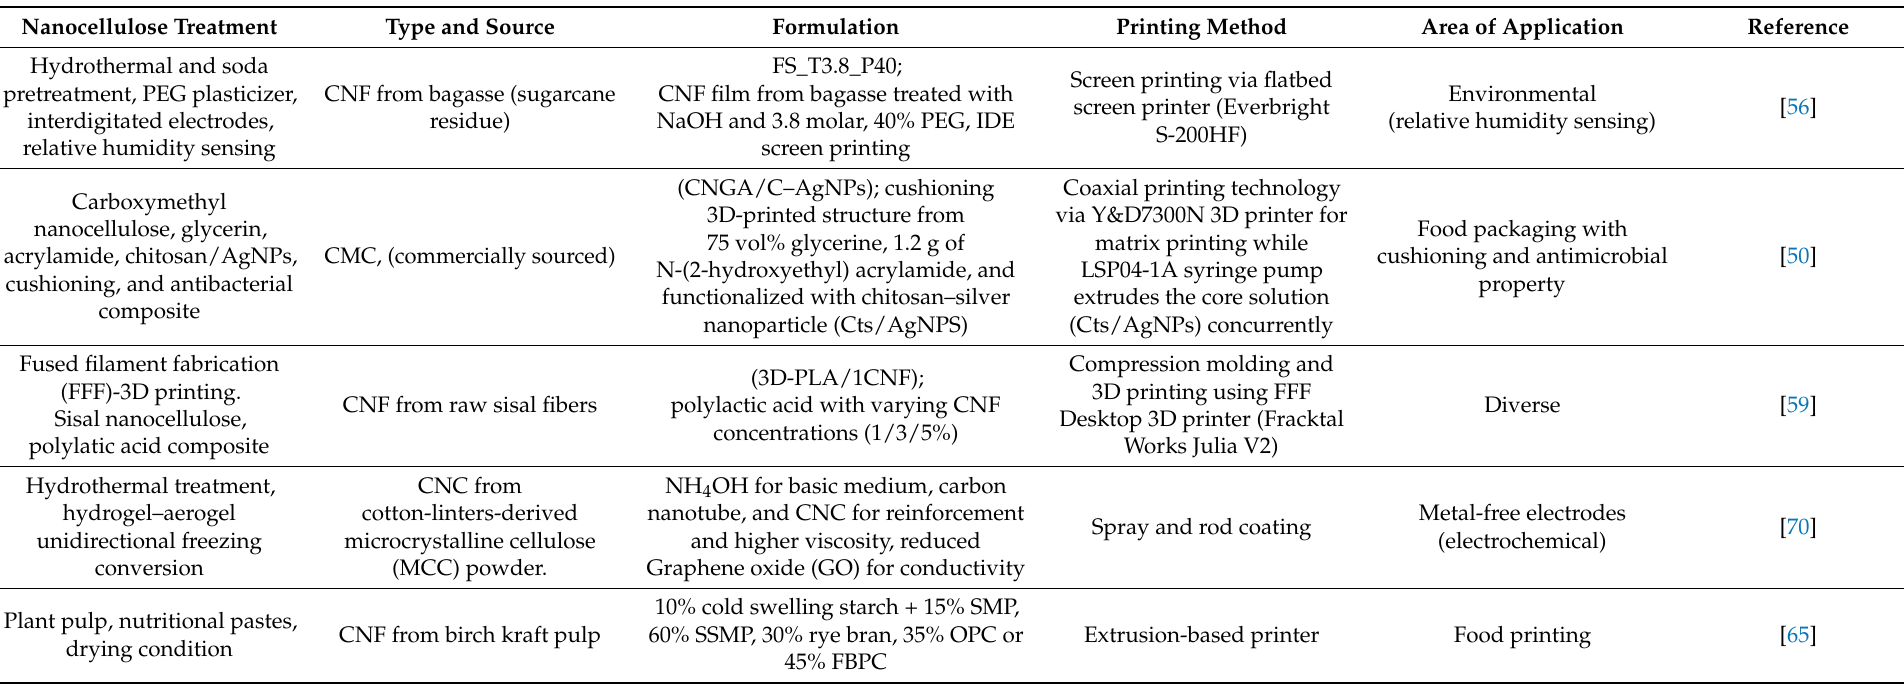
Table 1. Examples of 3D-printed nanocellulose composites, treatment, and formulation conditions for